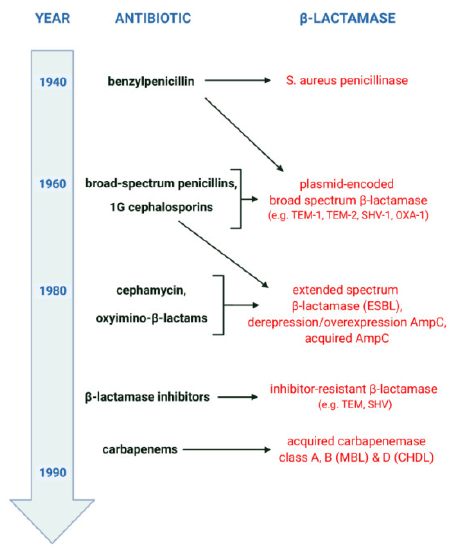
Figure 2. Timeline of the evolution of β-lactamases, created with BioRender (available online: https://biorender.com accessed on 23 May 2022). https://biorender.com, accessed on 23 May